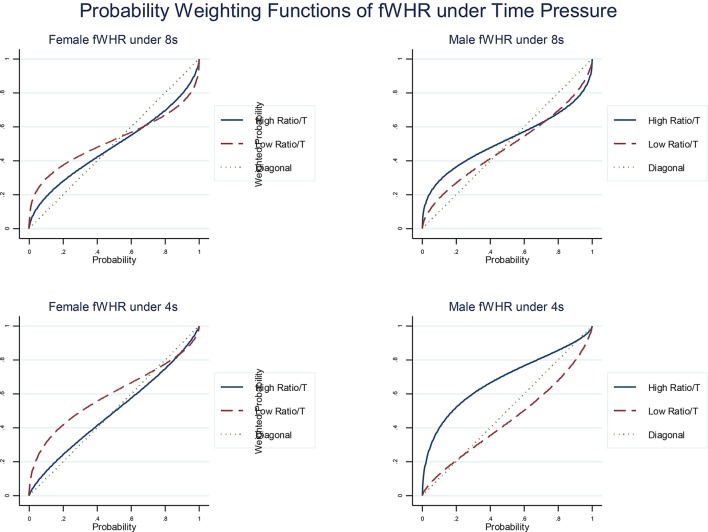
Estimated probability weighting functions of fWHR separated by male and female sub-group and 8 and 4 s time phases. The diagonal presents the actual probabilities shown in the lottery pairs in our experiment.8